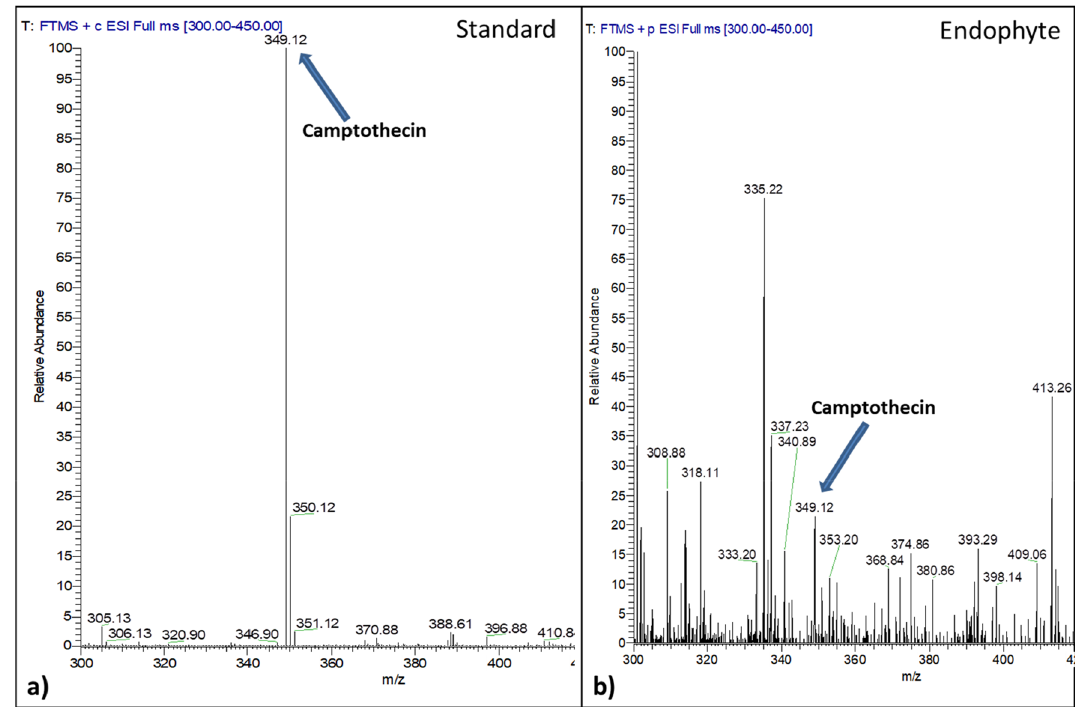
Figure 1. Identification of camptothecin from the endophytic extract using mass spectrometry. An m/z of 349.12 corresponding to camptothecin visualized in both ( a ) the standard and ( b ) the isolated endophyte.